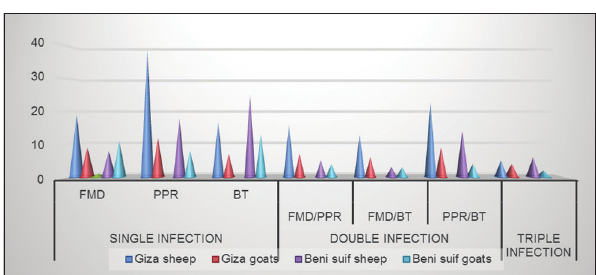
Figure-1: Comparison of single, double, and triple different viral infection in sheep and goats at Giza and Beni-Suef